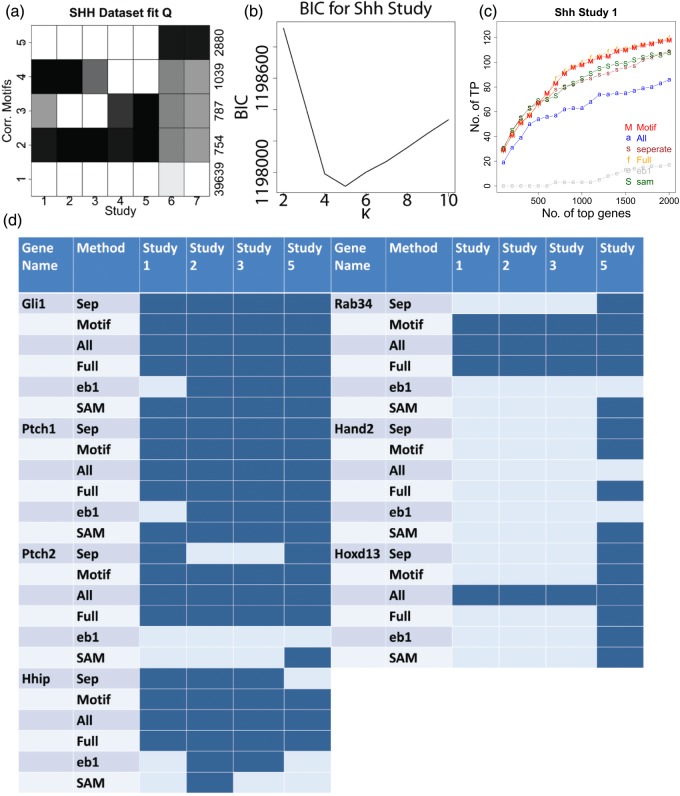
Results for the SHH data. (a) Motif patterns learned from the SHH data composed of 7 studies. (b) BIC plots for the SHH data. (c) Gene ranking performance for SHH study 1. The genes differentially expressed in dataset 8 (13somites_smo versus 13somites_wt) were obtained using separate limma. They were used as the gold standard. \documentclass[12pt]{minimal}
\usepackage{amsmath}
\usepackage{wasysym}
\usepackage{amsfonts}
\usepackage{amssymb}
\usepackage{amsbsy}
\usepackage{upgreek}
\usepackage{mathrsfs}
\setlength{\oddsidemargin}{-69pt}
\begin{document}
}{}${\mathrm {TP}}_d(r)$\end{document}, the number of genes in dataset 1 that are truly differentially expressed among the top \documentclass[12pt]{minimal}
\usepackage{amsmath}
\usepackage{wasysym}
\usepackage{amsfonts}
\usepackage{amssymb}
\usepackage{amsbsy}
\usepackage{upgreek}
\usepackage{mathrsfs}
\setlength{\oddsidemargin}{-69pt}
\begin{document}
}{}$r$\end{document} ranked genes by each method, is plotted against the rank cutoff \documentclass[12pt]{minimal}
\usepackage{amsmath}
\usepackage{wasysym}
\usepackage{amsfonts}
\usepackage{amssymb}
\usepackage{amsbsy}
\usepackage{upgreek}
\usepackage{mathrsfs}
\setlength{\oddsidemargin}{-69pt}
\begin{document}
}{}$r$\end{document}. (d) Differential status claimed by each method for known SHH pathway genes. Dark color indicates differential expression and light color represents non-differential expression.